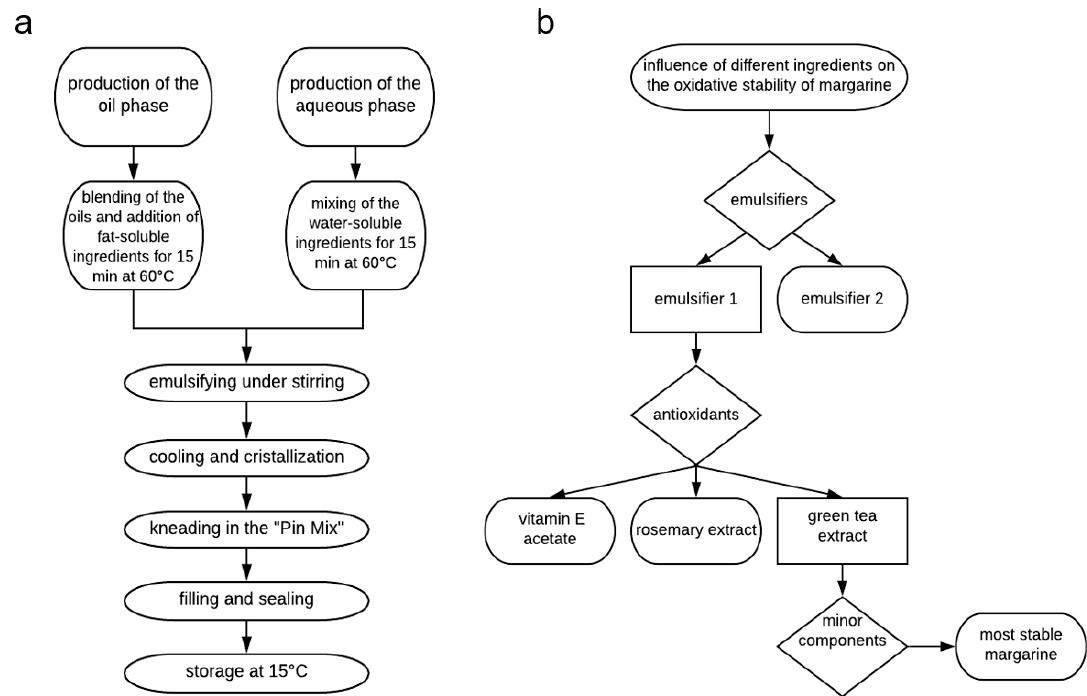
Figure 1. Margarine production scheme ( a ) and study design ( b ).